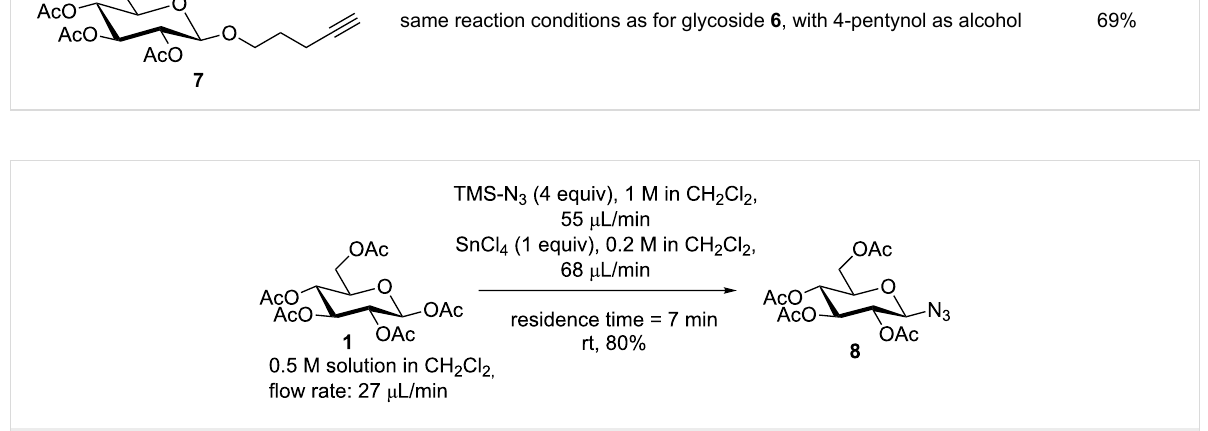
Scheme 5: Synthesis of azide-functionalized glycopyranoside 8